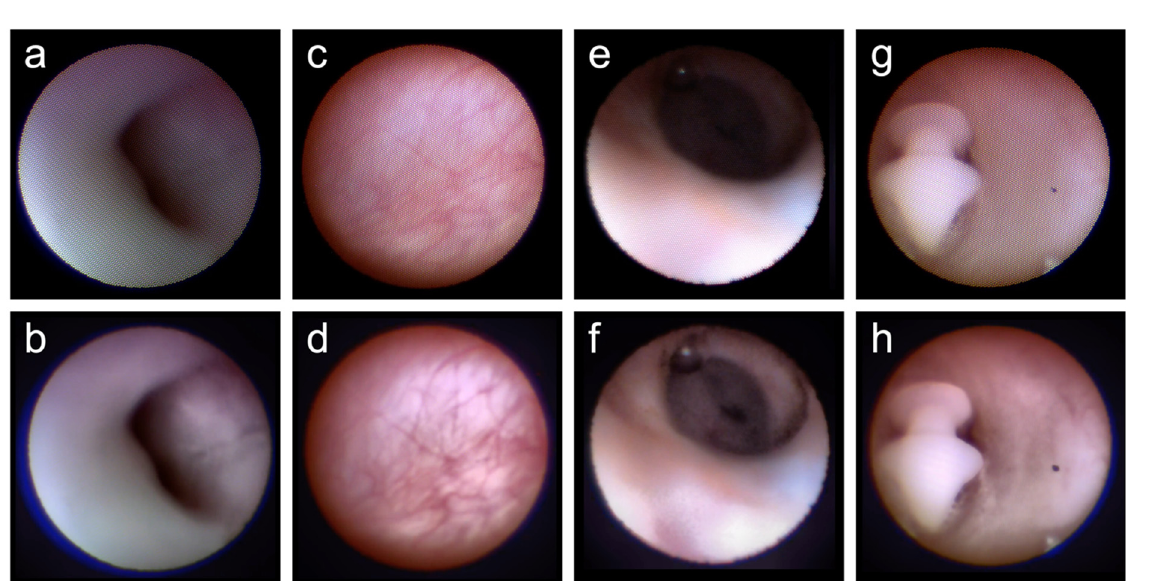
Figure 1. Original and post-processing representative images of the canaliculus ( a , b ), lacrimal sacs ( c , d ), nasolacrimal ducts ( e , f ), and intra-canal materials ( g , h ). The comb-structured artifact was observed in the original images, which were uneven and difficult to observe ( a , c , e , g ). However, in the post-processing images, this artifact was removed by image processing, and the visibility was improved ( b , d , f , h ). The blood vessels in the lacrimal sac mucosa were more highlighted in the processed image than in the original image ( c , d ). On comparing the nasolacrimal duct images, the luminal structures that were obscured in the original image ( e ) were visible in the processed image ( f ).